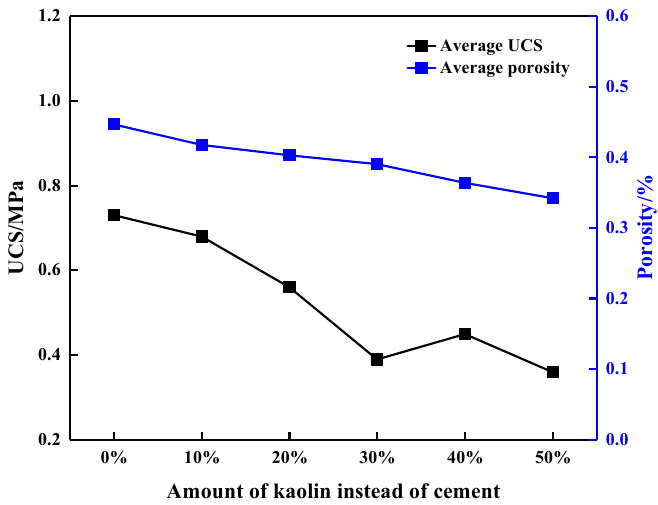
Figure 11. Comparison of the relationship between UCS and porosity of CGFB with different amount of kaolin instead of cement.